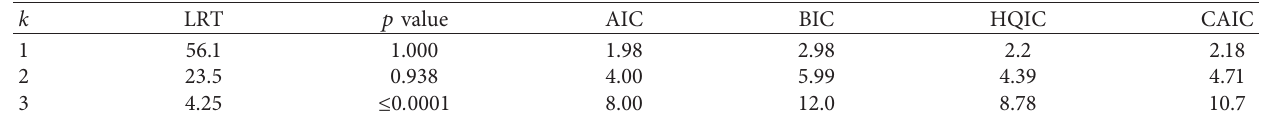
Figure 4: Power results at k � 4 with parameters (0.8, 0.05, 0.11, 0.04, 0.99, 0.17, 2.0, 4.0). Table 7: Sequential results for application 1 at n � 20.